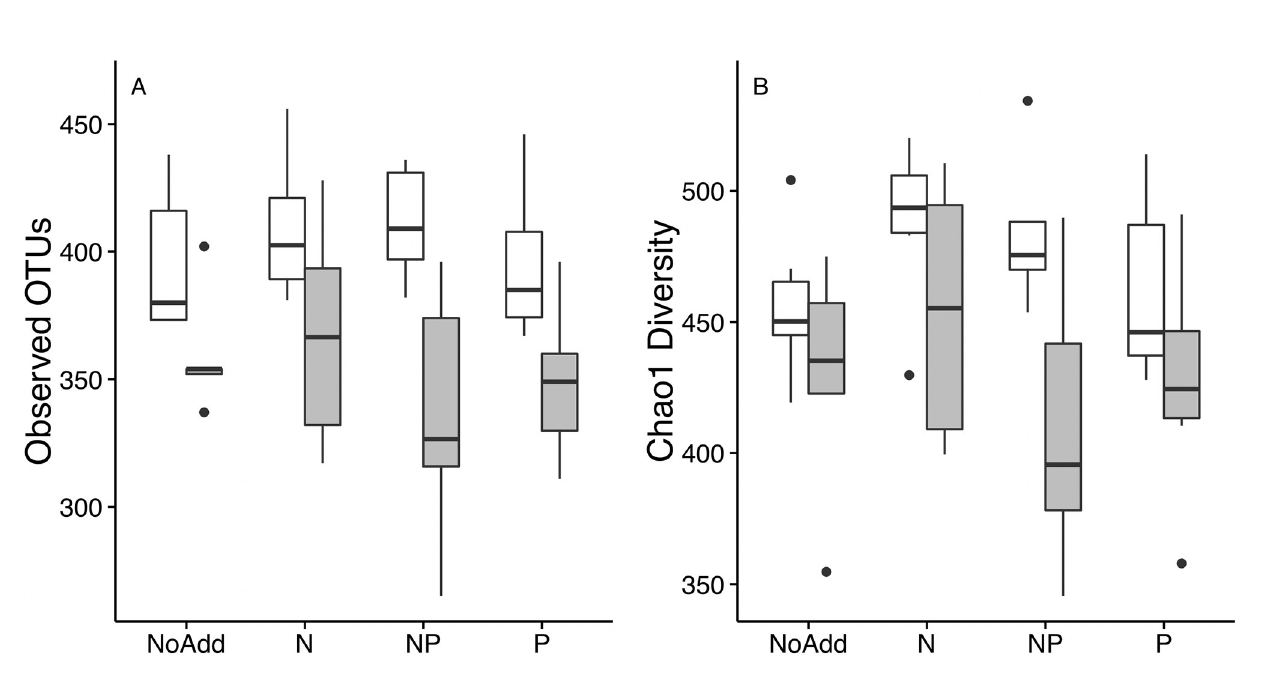
Fig 4. Alpha diversity metrics of microcosm communities after 70 day incubations. pH adjustment treatments are shown in grey, while unadjusted treatments are shown in white. Treatments incubated at 6 and 15˚C were not significantly different and are combined for simplicity, thus each bar represents 6